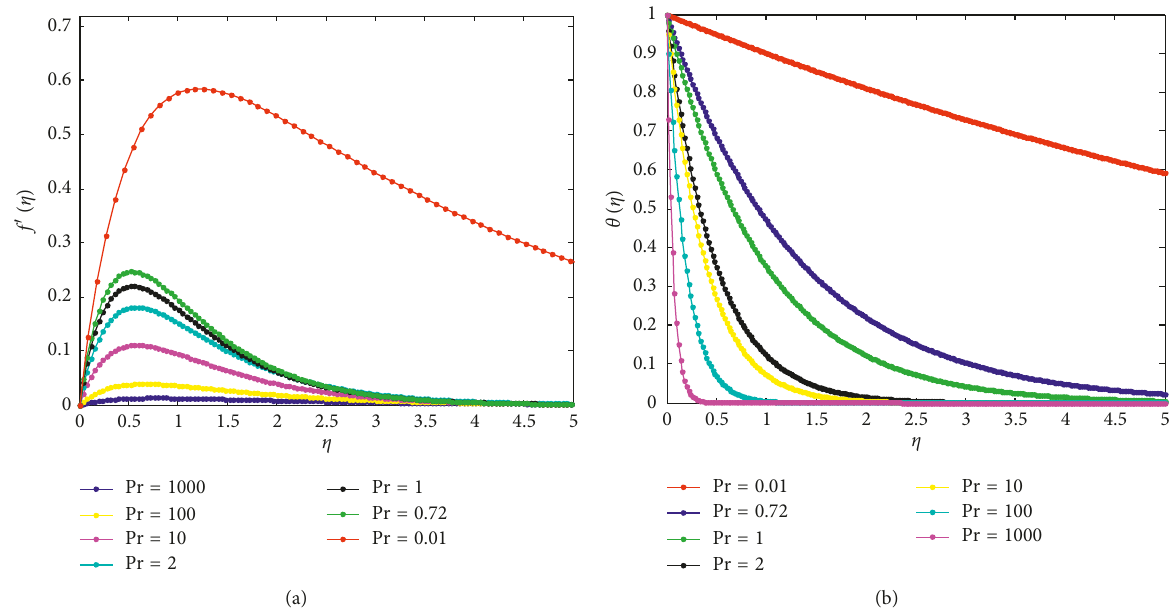
Figure 18: (a) Effects of Prandtl number on the velocity profile for Al profile for Al 2 O 3 nanoparticle.